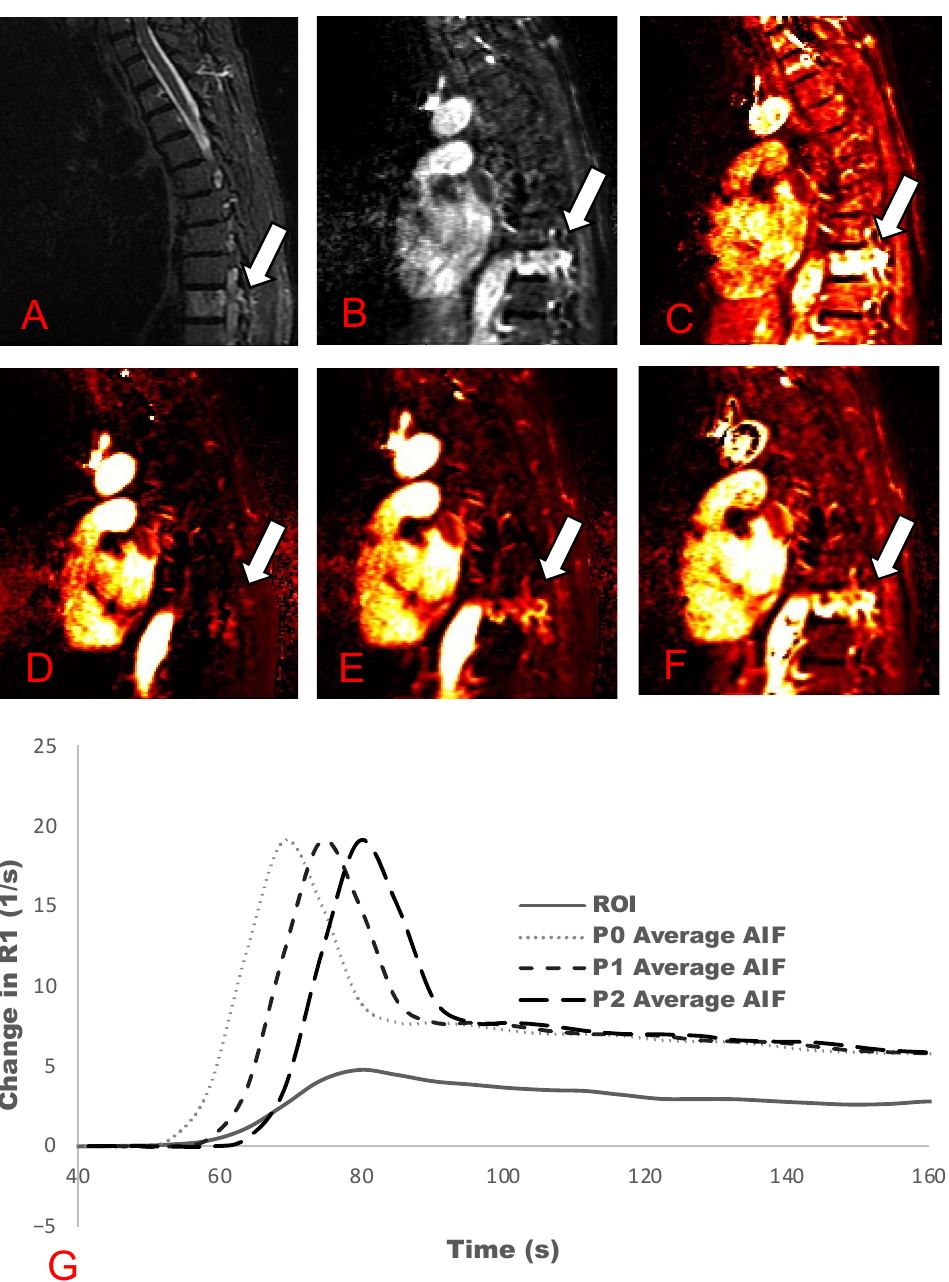
Figure 1. Active metastasis in T9 (Table 1: Patient 10). Multiple phase-shift delays and associated plasma volume (V p ) maps are presented. ( A ) STIR map; ( B ) Contrast uptake map; ( C ) K trans map; ( D ) V p maps without a phase-shift delay; ( E ) one phase-shift delay; and ( F ) two phase-shift delays. ( G ) AIF graph demonstrating the phase-shift delay at zero (P0), one (P1), and two (P2) phase shifts of the average AIF curve. Solid line demonstrates lesion ROIs.